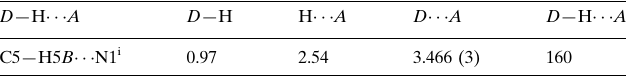
Hydrogen-bond geometry (A˚ , (cid:2)